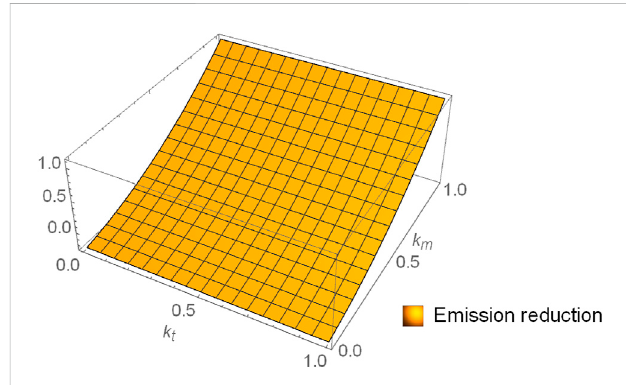
FIGURE 9 The impact of k t and k m on the total amount of emission reduction.